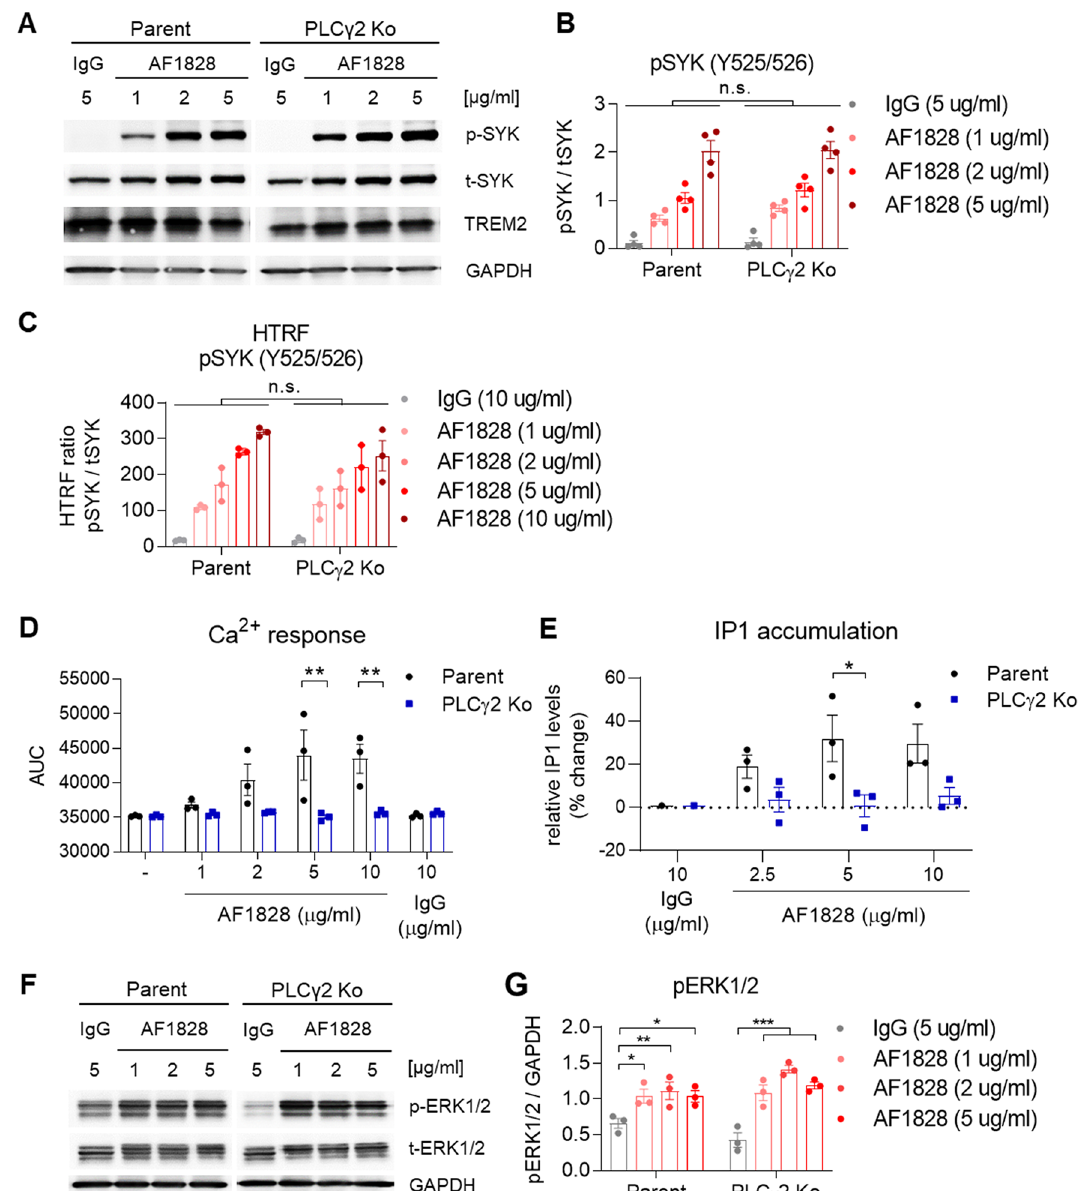
Figure 3. PLCγ2 regulates TREM2-mediated signalling in iPSC- derived macrophages. ( A ) Representative Western blots showing phospho-SYK after TREM2 ligation using AF1828 in Parent and PLCγ2 Ko cells. ( B ) Quantification of SYK phosphorylation after TREM2 ligation shows no effect of PLCγ2 deficiency, n = 4. Full immunoblot images are presented in Supplementary Fig. 9. ( C ) pSYK HTRF assay confirms similar phosphorylation levels upstream of PLCγ2 upon TREM2 stimulation in Parent and PLCγ2 Ko cells, n = 3. ( D ) Ca 2+ flux induced by TREM2 ligation is prevented in PLCγ2 Ko cells. n = 3 ( E ) PLCγ2 deficiency abolishes TREM2-induced IP1 production as determined by HTRF assay. n = 3 ( F ) Representative Western blots and ( G ) quantification of ERK1/2 phosphorylation shows no major difference between Parent and PLCγ2 Ko cells. Full immunoblot images are presented in Supplementary Fig. 10. Data shown represent mean ± SEM, two-way ANOVA followed by Bonferroni’s multiple comparison test, * p < 0.05, ** p < 0.01, *** p <